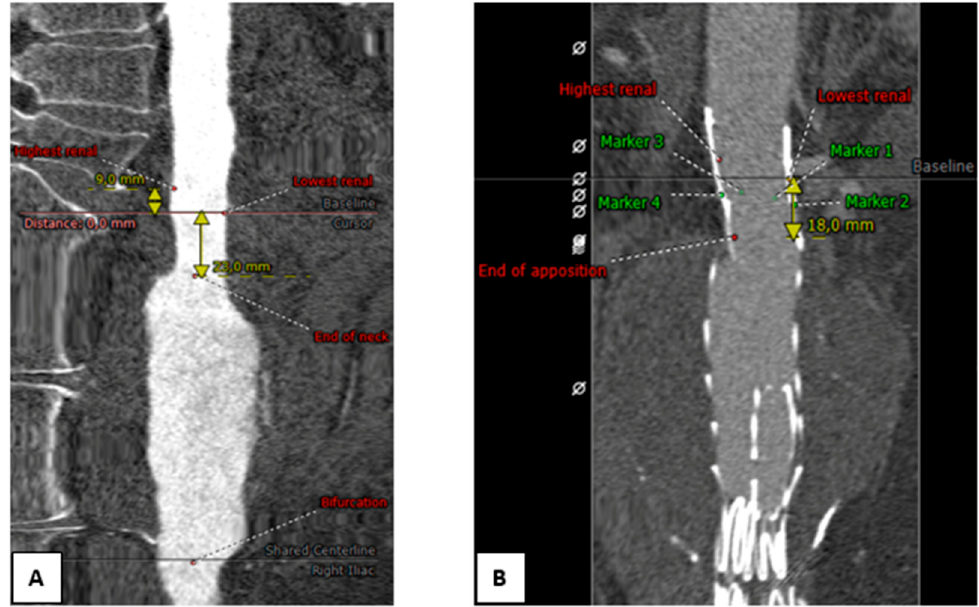
Figure 1. Measurements in 3mensio vascular workstation on the preoperative computed tomography angiography (CTA) scan. ( A ) Baseline is set to the distal edge of the lowest renal artery. The end of the aortic neck is defined as the first slice that exceeds a 10% diameter increase compared with baseline; ( B ) positioning of three-dimensional coordinate markers. CTA coordinates are obtained from the lowest and highest renal arteries (red), the end of circumferential apposition (red), and of four radiopaque markers that define the proximal edge of the endograft fabric (green). A center lumen line was semi-automatically created from the celiac trunk to the aortic bifurcation. The baseline was set at the inferior border of the orifice of the lowest renal artery. In case of an accessory renal artery which was not over-stented, this accessory renal artery was used as baseline. The distal end of the aortic neck on the preoperative CTA scans was defined as the first slice with >10% diameter increase compared with baseline [10]. The neck length was measured over the centerline between the renal artery baseline and the distal end of the neck. On the preoperative CTA scan, three-dimensional (3D) coordinate markers were placed at the inferior border of the orifice of the left and right renal artery and at the end of the aortic neck. On the post-operative CTA scan, 3D coordinate markers were placed at the renal artery orifices, at the radiopaque markers that are located 1–2 mm below the proximal edge of the endograft fabric, and at the first slice where circumferential apposition between endograft and aortic wall was lost (Figure 1B). Localized gutters